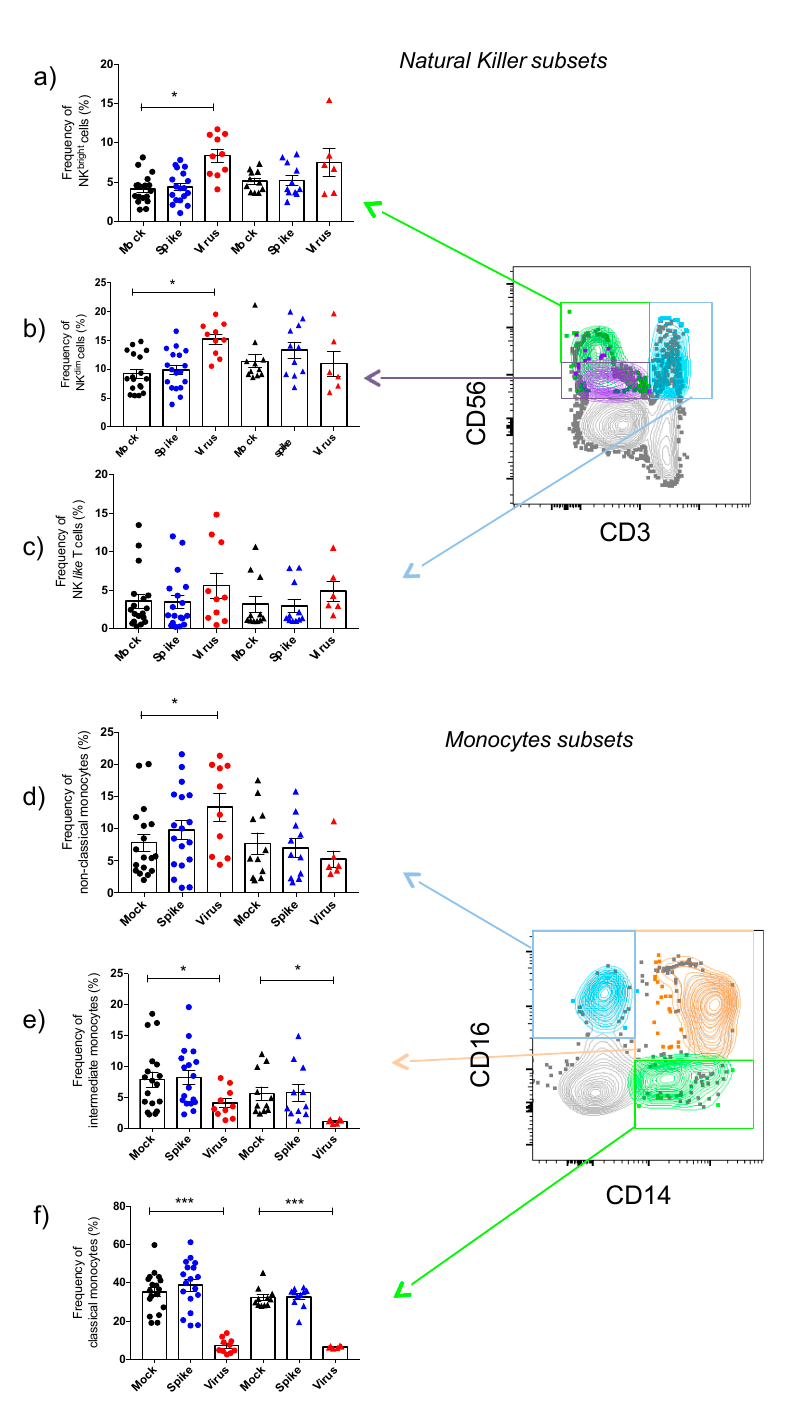
Figure 2. Effects of SARS-CoV-2 on natural killer and monocytes subsets. The percentage of natural killer (NK) subsets are displayed for NK bright (CD3 − CD56 high CD16 low ) ( a : green color in the dot plot), NK dim (CD3 − CD56 low CD16 high ) ( b : purple), and NK-like T cells (CD3 + CD56 + ) ( c : blue) in both groups, unexposed and SARS-CoV-2 exposed (COVID-19), up to 48 h of cell cultivation in the presence of spike protein and live SARS-CoV-2. The percentage for monocytes subsets were divided in nonclassical monocytes (CD14 − CD16 + ) ( d : blue color), intermediate monocytes (CD14 + CD16 + ) ( e : orange color), and classical monocytes (CD14 ++ CD16 − ) ( f : green) on cell cultivation with antigens. The data are representative of 2–5 different experiments. * p < 0.05, ** p < 0.01, *** p <